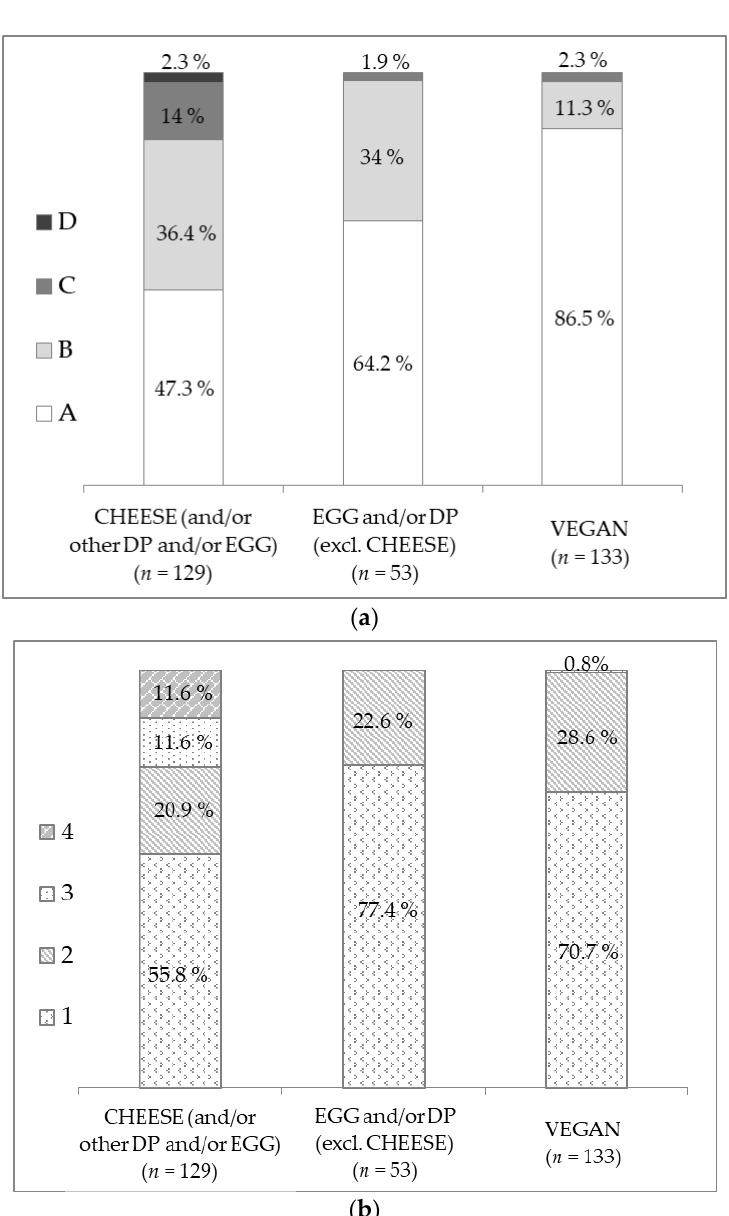
Figure 3. Nutrient profile of the three sub-categories of vegetarian main dishes: “CHEESE (and / or other DP and / or EGG)” ( n = 129), “EGG and / or DP (excl. CHEESE)” ( n = 53) and “VEGAN” ( n = 133), according to ( a ) Nutri-Score classes (A, B, C and D); ( b ) SAIN,LIM classes (1, 2, 3 and 4).